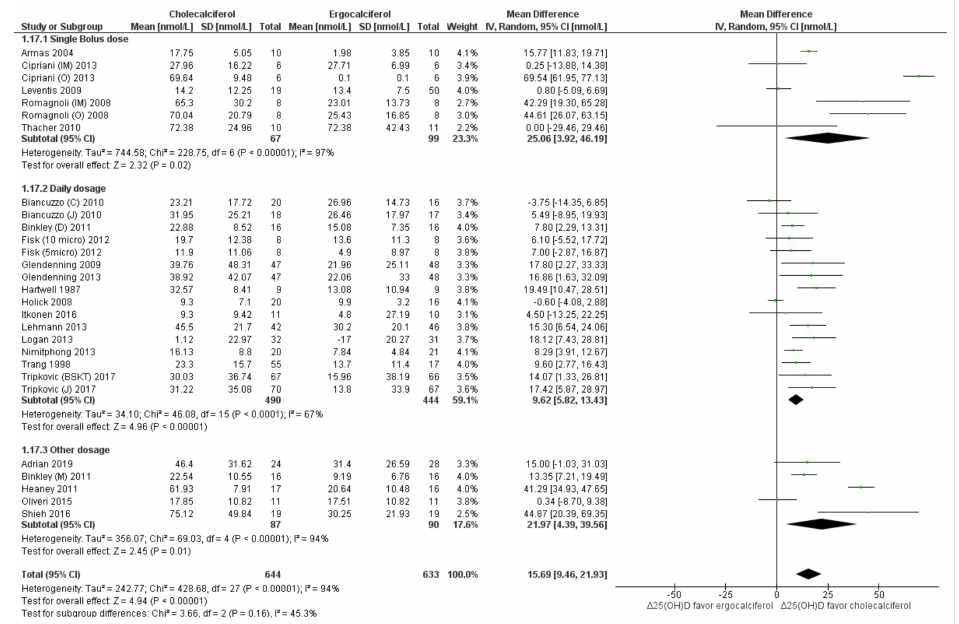
Figure 2. Forrest plot analysis of serum total 25(OH)D: sub-group analysis based on the frequency of doses. Legend: Forrest plot of random effect meta-analysis comparing the effects of cholecalciferol vs. ergocalciferol supplementation on net changes in 25(OH)D concentrations favored cholecalcif- erol. “ ∆ 25(OH)D” denotes the change in total 25(OH)D concentrations from baseline (net change), “diamond” image denotes the mean differences (with 95% confidence interval). The pooled results indicate a mean difference of 15.69 nmol/L (95% confidence interval: 9.46–21.93 nmol/L) favoring cholecalciferol supplementation. Sub-group analyses in relation to the dosage frequency (single stat or bolus dose vs. daily dosage) are presented. Sub-group analyses show higher serum 25(OH)D levels among the cholecalciferol supplemented group as compared to ergocalciferol group. However, the studies are highly heterogeneous ( I 2 >